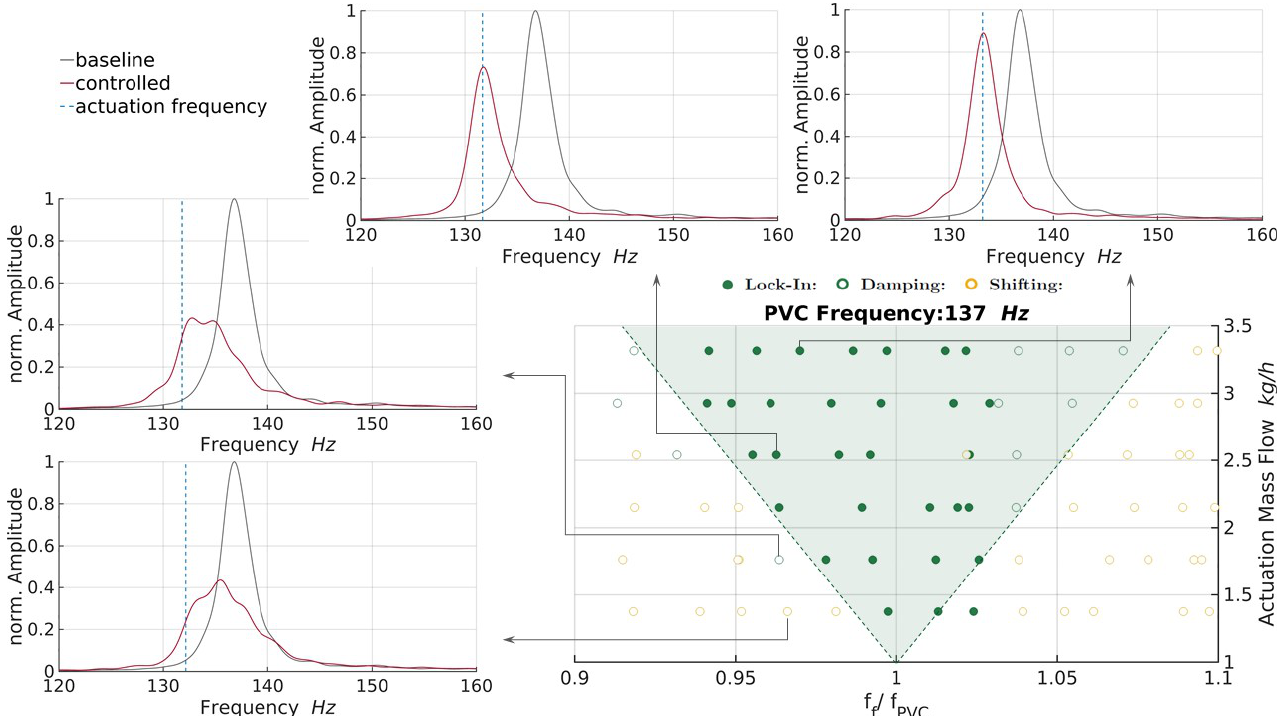
Figure 9. Validation of flow control authority. Lock-in diagram (bottom right) and surrounding example of spectra show lock-in, damping, and shifting response of the PVC to the